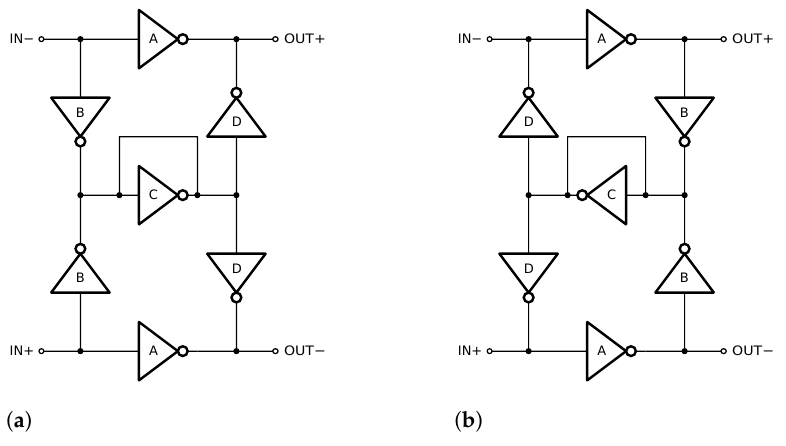
Figure 7. ( a ) Barthelemy (B) OTA diagram [3], and ( b ) Vieru (V) OTA circuit diagram